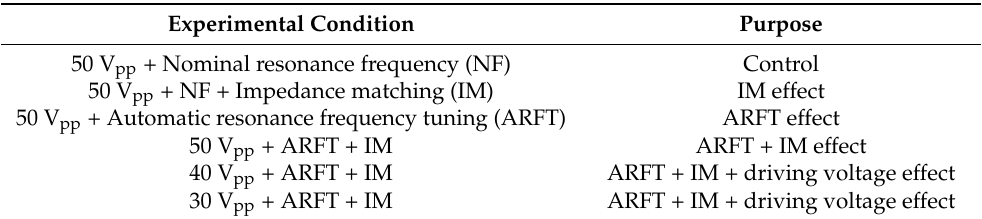
Table 2. Effects of automatic resonance frequency tuning (ARFT) and impedance matching (IM) on experimental